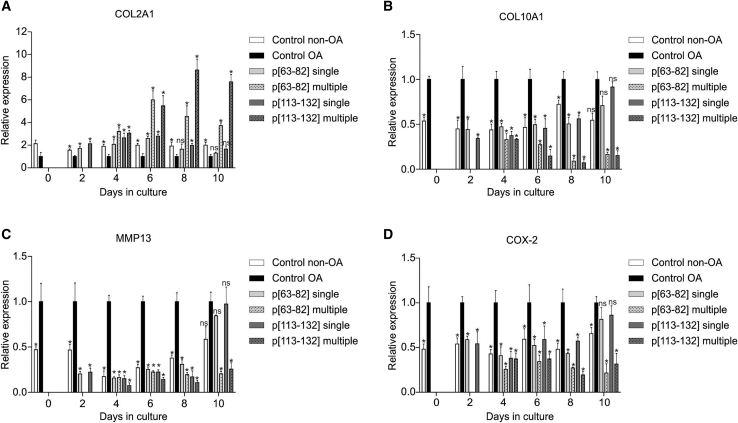
Duration of chondrocyte phenotype modulation by BMP7-derived peptidesA pool of OA-HACs (n = 3 donors) was cultured in the presence or absence of 100 nM peptides p[63−82] or p[113−132] and compared to a pool of human articular chondrocytes from a non-OA source. The medium was changed every 2 days. Peptides were added at the start of the experiment and subsequently at every medium change (multiple) or only at the start of the experiment and not during every subsequent medium change (single). At days 0, 2, 4, 6, 8, and 10 in culture, samples were harvested and analyzed for the expression of the indicated mRNAs by quantitative real-time PCR (normalized for 28S rRNA expression) (A) COL2A1 mRNA expression. (B) COL10A1 mRNA expression. (C) MMP13 mRNA expression. (D) COX-2 mRNA expression. In graphs, error bars represent mean ± SEM; data are presented relative to the “control OA” condition of each time point. Statistical differences were calculated to control conditions. Error bars represent mean ± SEM, and statistical significance for peptide conditions or control non-OA versus control OA condition as determined by unpaired two-tailed Student’s t test is represented as ∗p < 0.05, ∗∗p < 0.01, and ∗∗∗p < 0.001.